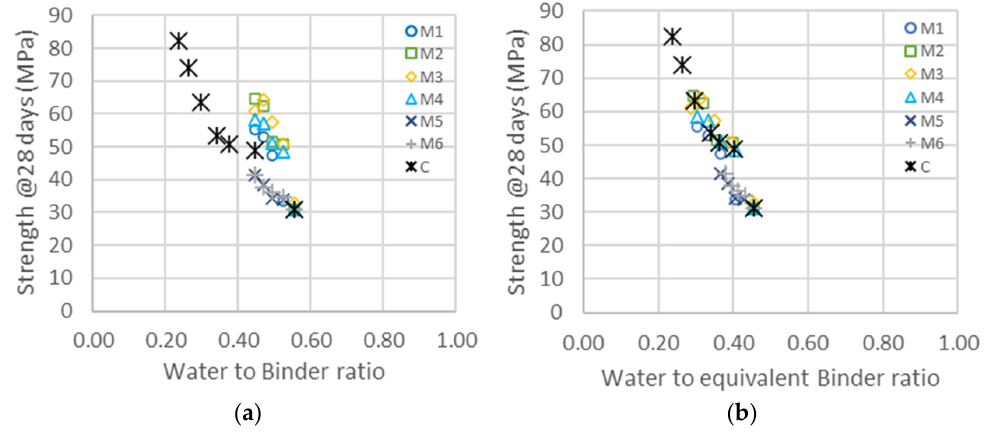
Figure 8. ( a ) Compressive strength as a function of the water-to-binder ratio for the different types of metakaolin (M1–M6) and cement addition (C). ( b ) Same data represented as a function of the equivalent binder-to-water ratio, following Equation (2), and considering only cement and metakaolin. The shift factors for each series are given in Table 11 ( X k ternary system).